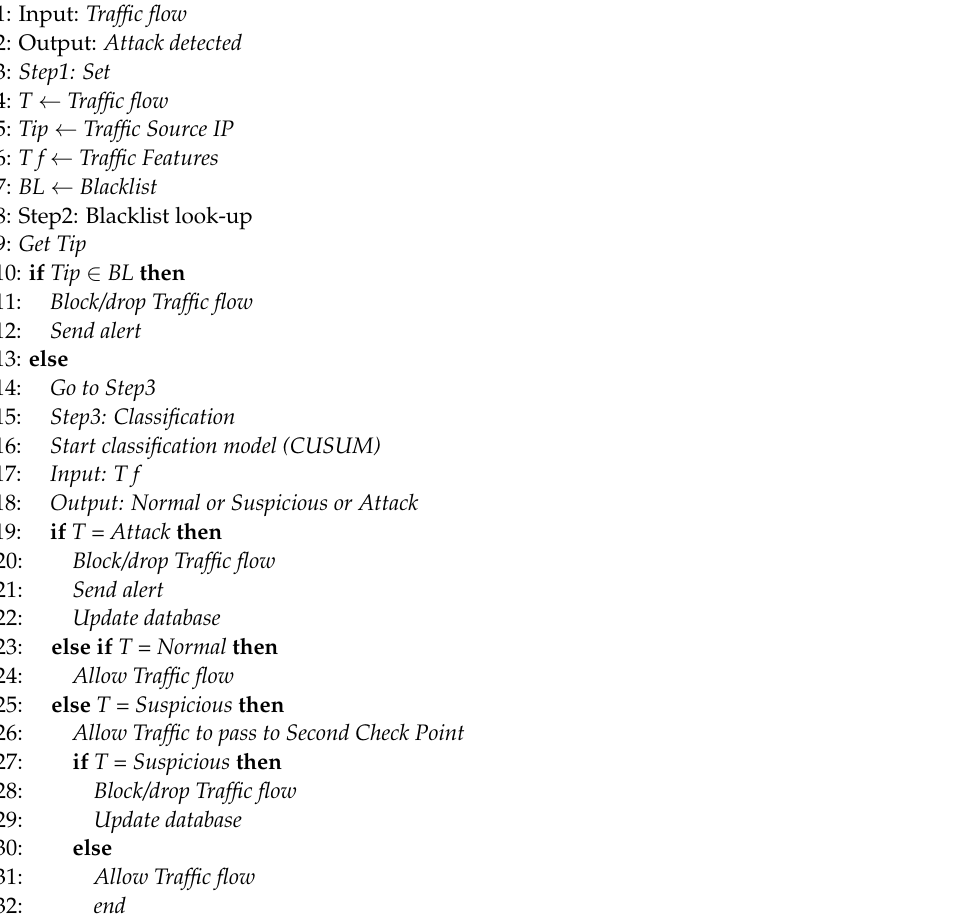
Algorithm 2: Proposed Anomaly Mitigation